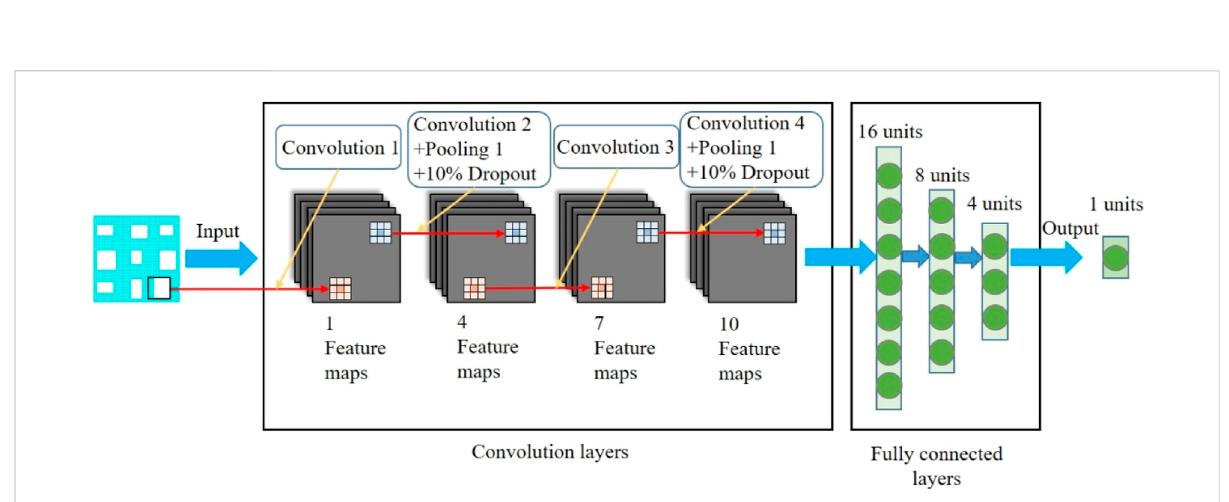
FIGURE 4 The convolutional neural network model constructed in the present